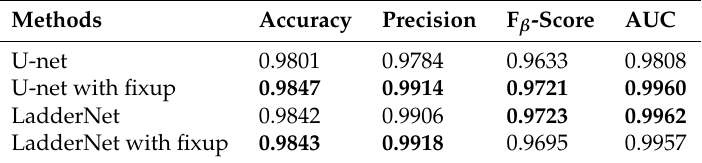
Table 3. Results on CORO data